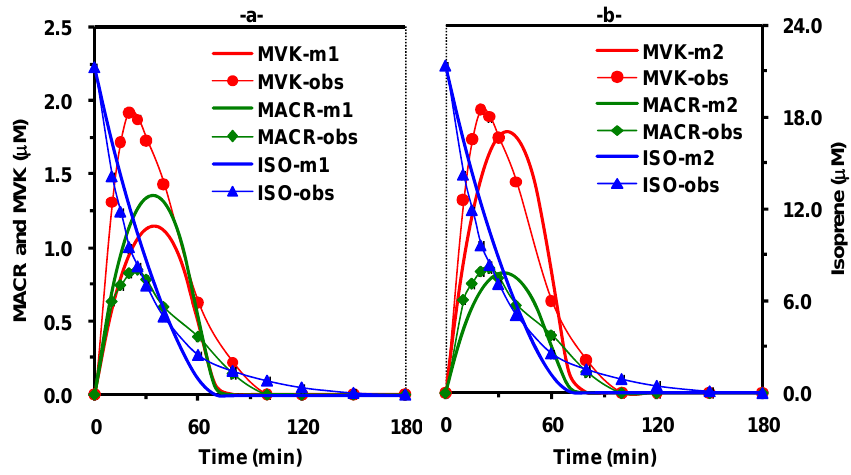
Fig. 6. Model-measurement comparison for isoprene, methyl vinyl ketone (MVK), and methacrolein (MACR) abundances during the aqueous oxidation of isoprene. (a) The model simulation was performed with the initial kinetic parameters (m1). (b) The model simulation was performed with the adjusted kinetic parameters (m2). obs, observed